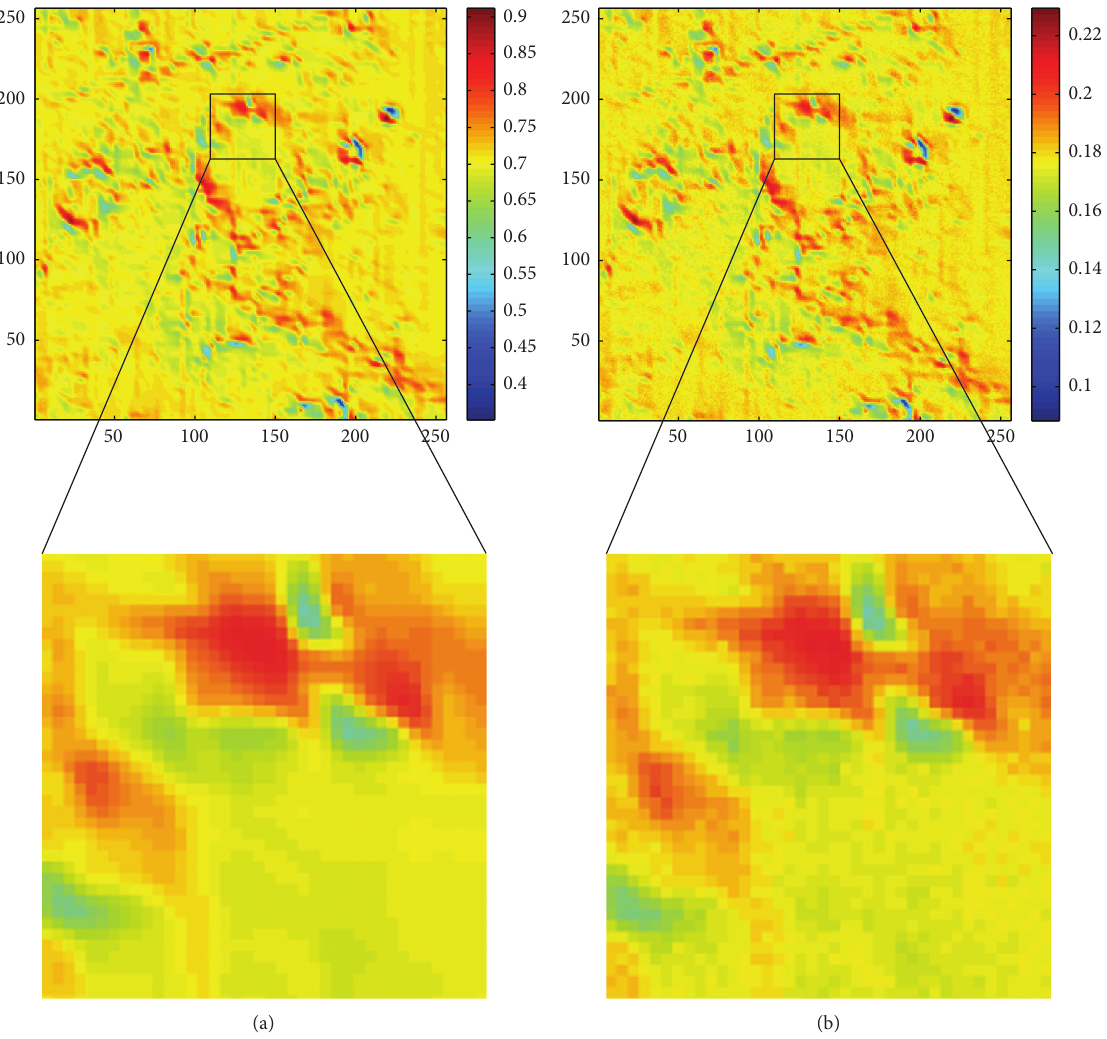
Figure 15: Simulation results of the uniform distribution of the samples (size: 256 × 256 ). (a) diffusion only; (b) diffusion and reflectance of the samples (sample rate =